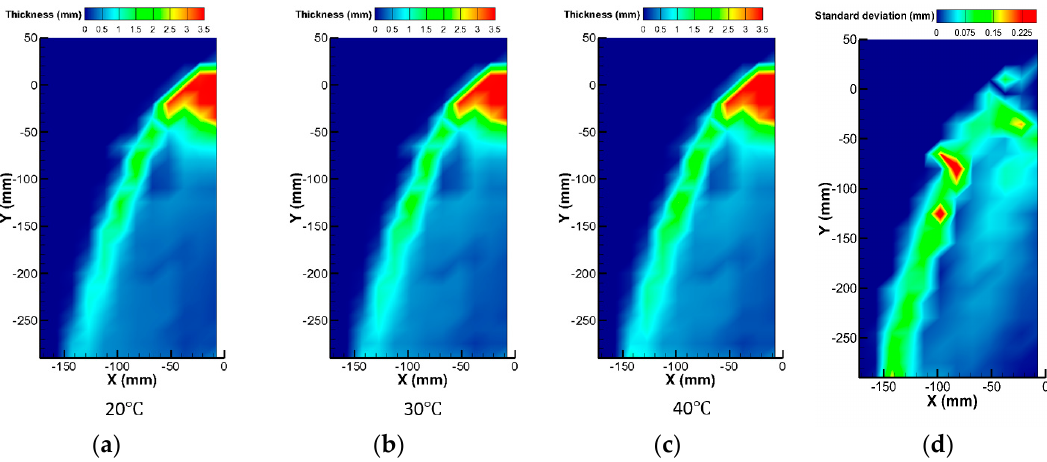
Figure 18. Liquid film thickness with different temperature conditions: ( a ) 20 ◦ C; ( b ) 30 ◦ C; ( c ) 40 ◦ C; and ( d ) standard deviation